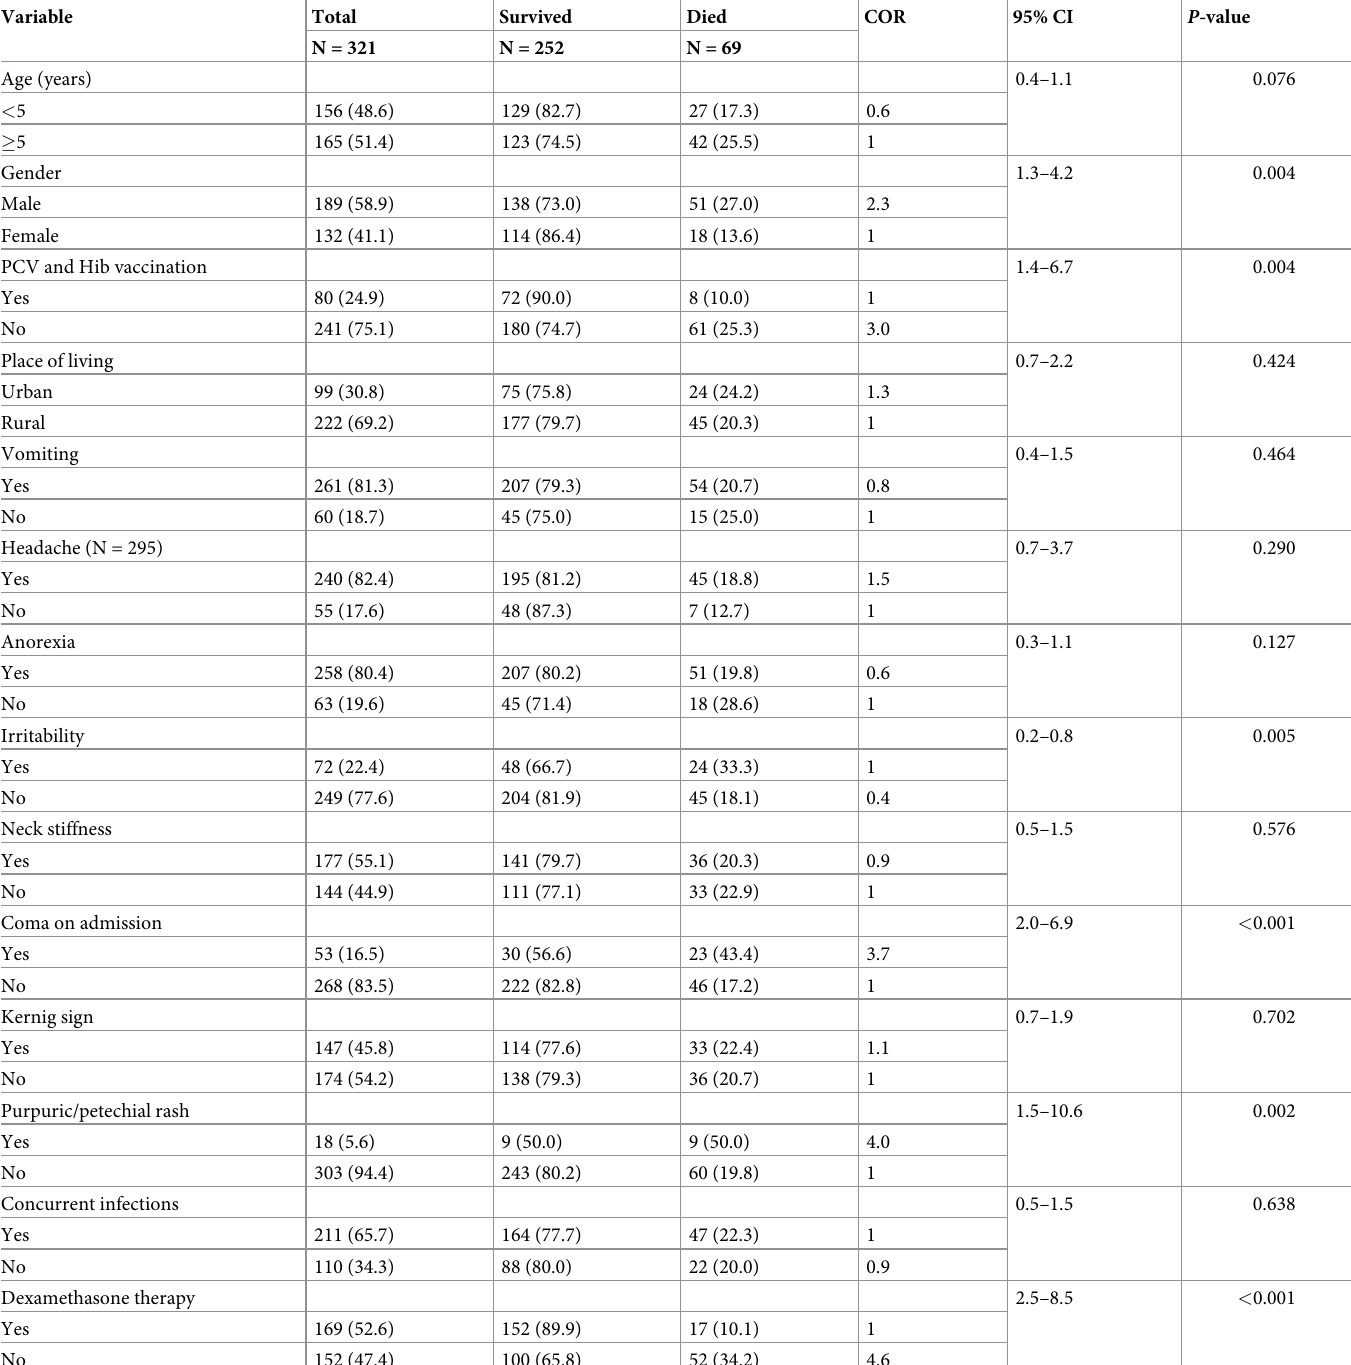
Table 5. Chi-square test of the factors associated with mortality in ABM